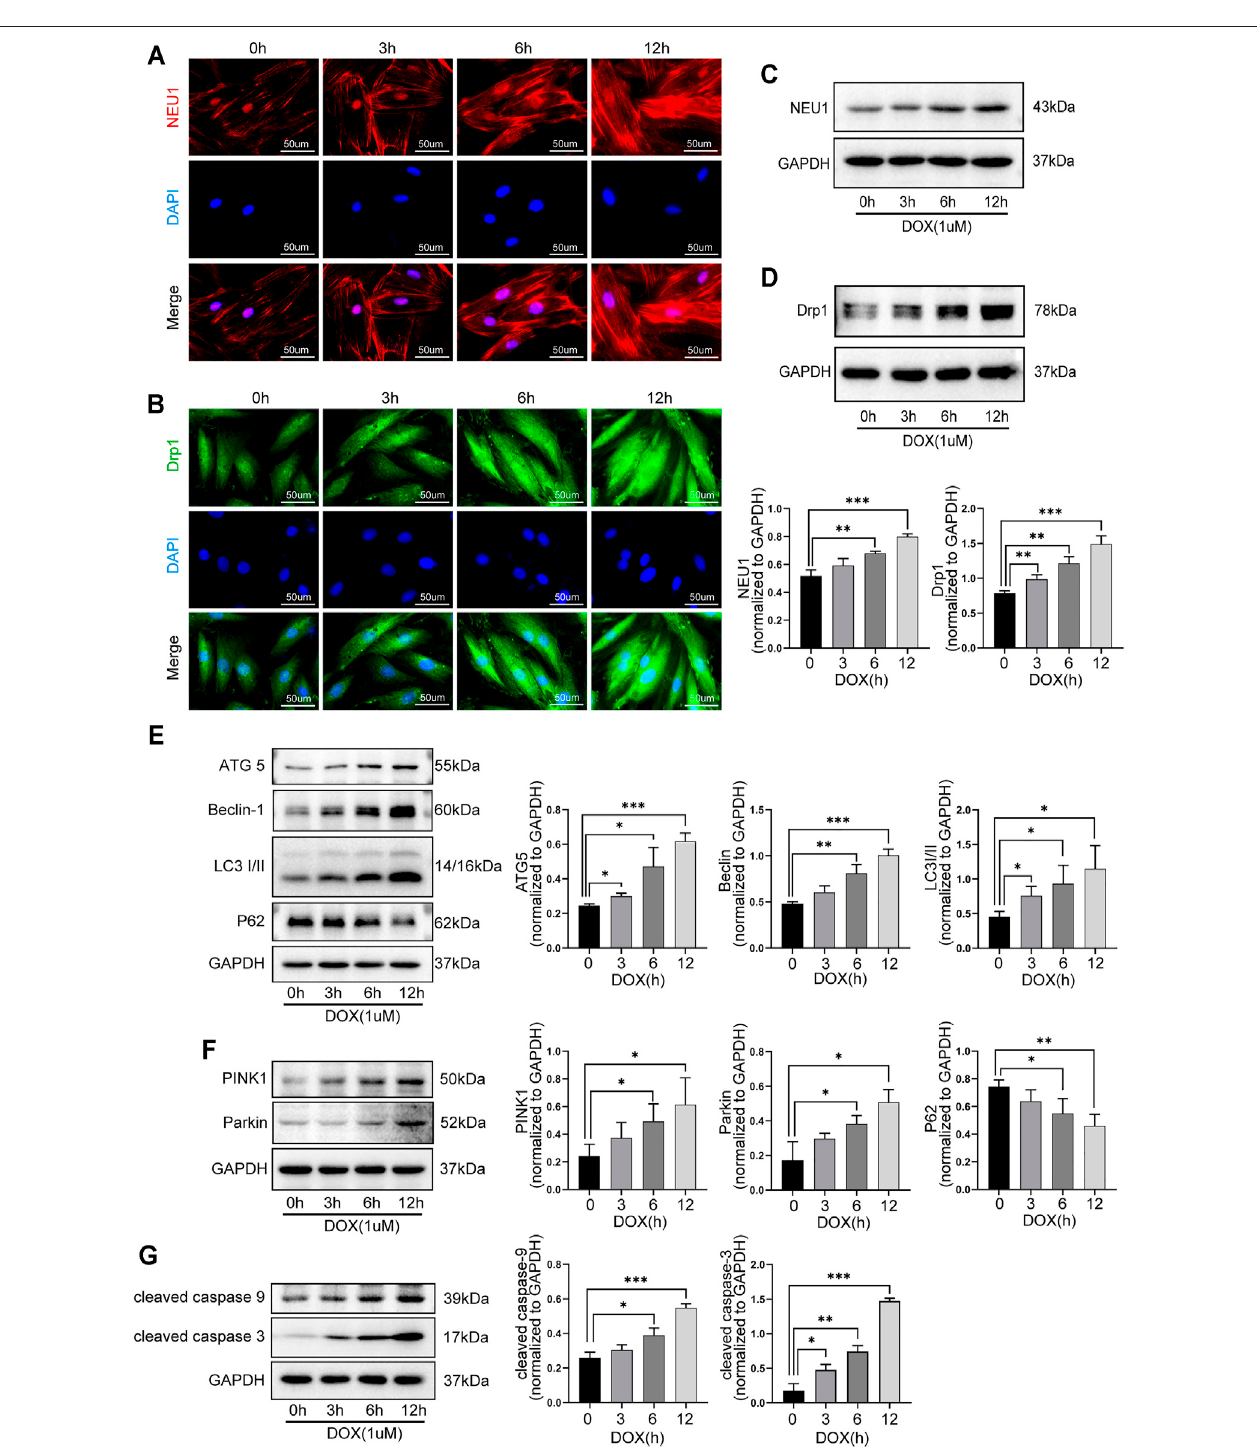
FIGURE 5 | DOX induced the upregulation of NEU1 and dysfunction of autophagy and mitophagy in H9C2 cells in a time-dependent manner. Representative immuno fl uorescentimagesofNEU1 (A) andDrp1 (B) expressionsinH9C2cellsthatsufferedfromDOXexposurefor0,3,6,and12 h.Westernblotanalysisshowedthat prolonged DOX exposure gradually increased expressions of NEU1 (C) and Dpr1 (D) in H9C2 cells. (E) Prolonged DOX exposure increased the expressions of autophagic markers including ATG5, Beclin 1, and LC3I/II, while it decreased the expression of P62 in H9C2 cells. (F) Prolonged DOX exposure enhanced the expressions of mitophagy-related markers like PINK1 and Parkin in H9C2 cells. (G) Prolonged DOX exposure activated apoptotic markers including caspase-3 and caspase-9 in H9C2 cells. (* p < 0.05, ** p < 0.01, *** p < 0.001).